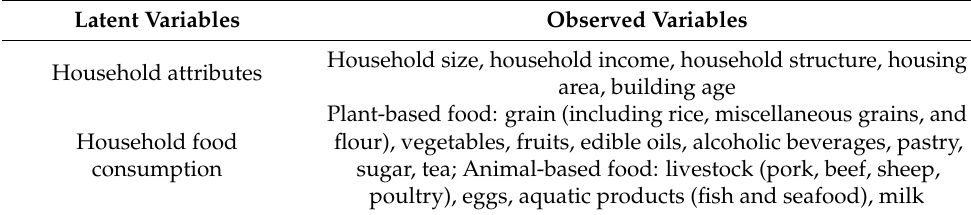
Table 1. Components and survey variables in questionnaire.